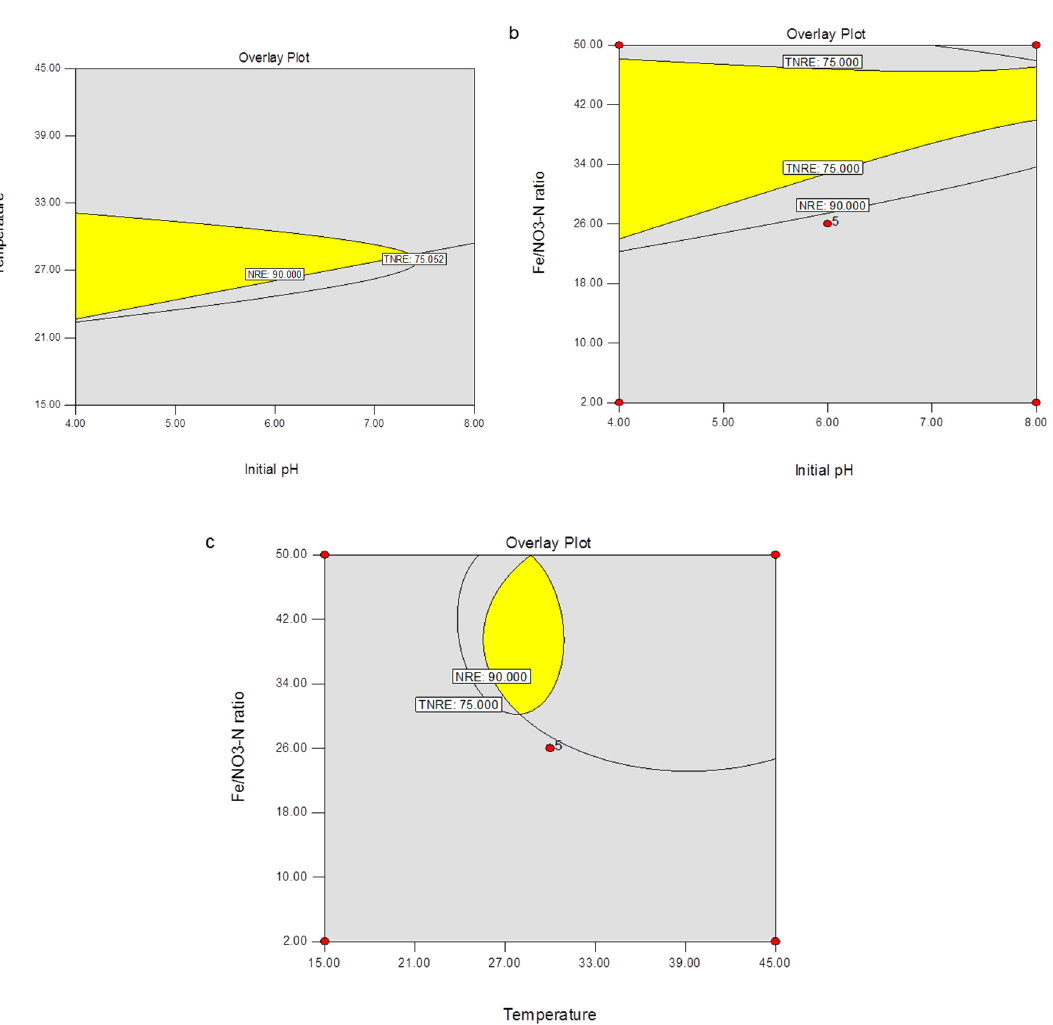
Figure 6. Overlay plot for the optimal region identified based on interactive influence of ( a ) pH versus temperature (constant Fe / NO 3 -N of 26); ( b ) pH versus Fe / NO 3 -N (constant temperature of 30 ◦ C); ( c ) temperature versus Fe / NO 3 -N (constant pH of 6.0).